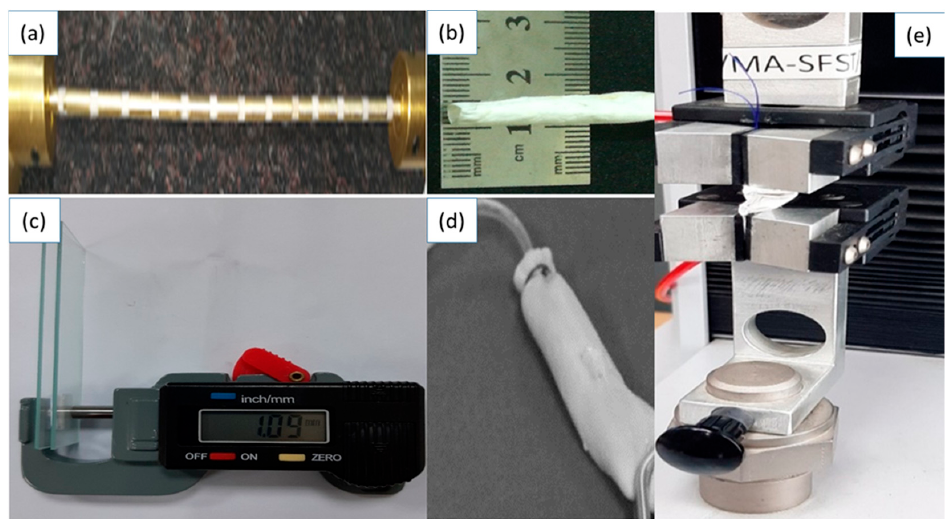
Figure 1. Fabrication and testing of vascular grafts. ( a ) Cylindrical collectors with conductive and non-conductive seg- ments, ( b ) electrospun cylindrical vascular graft, ( c ) Thickness measurement, ( d ) bursting pressure measurement, ( e ) measurement of tensile strength and suture retention strength.